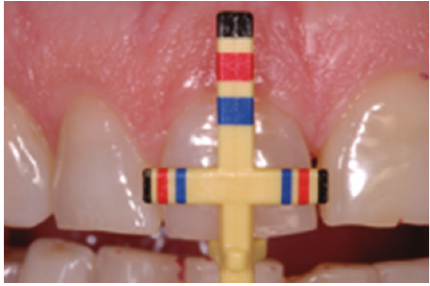
Figure 5: Chu’s probe for esthetic proportions. Table1:Qualitativeevaluationofalteredpassiveeruptioninsiblings of treated patients.